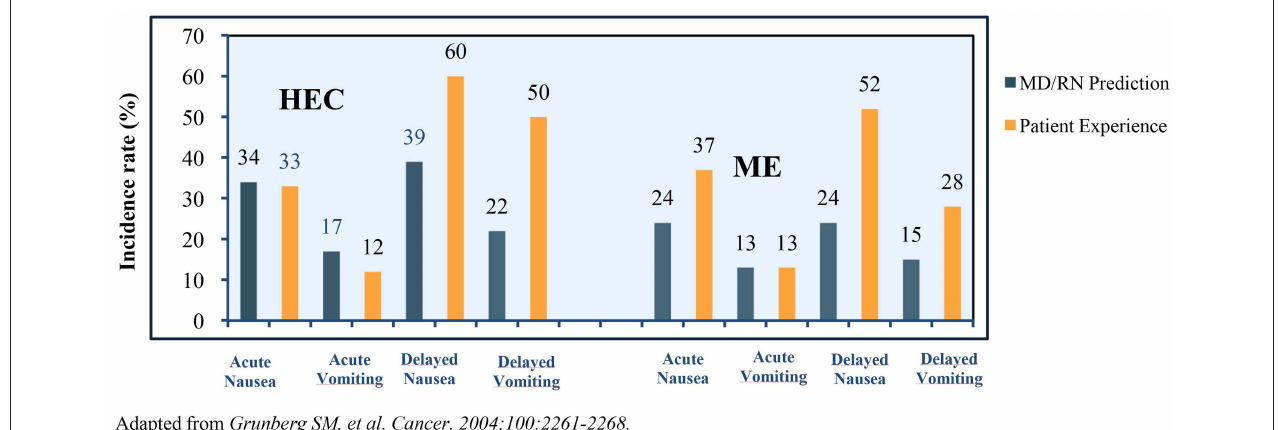
FIGURE 2 | Incidence rates of nausea and vomiting (actual vs.